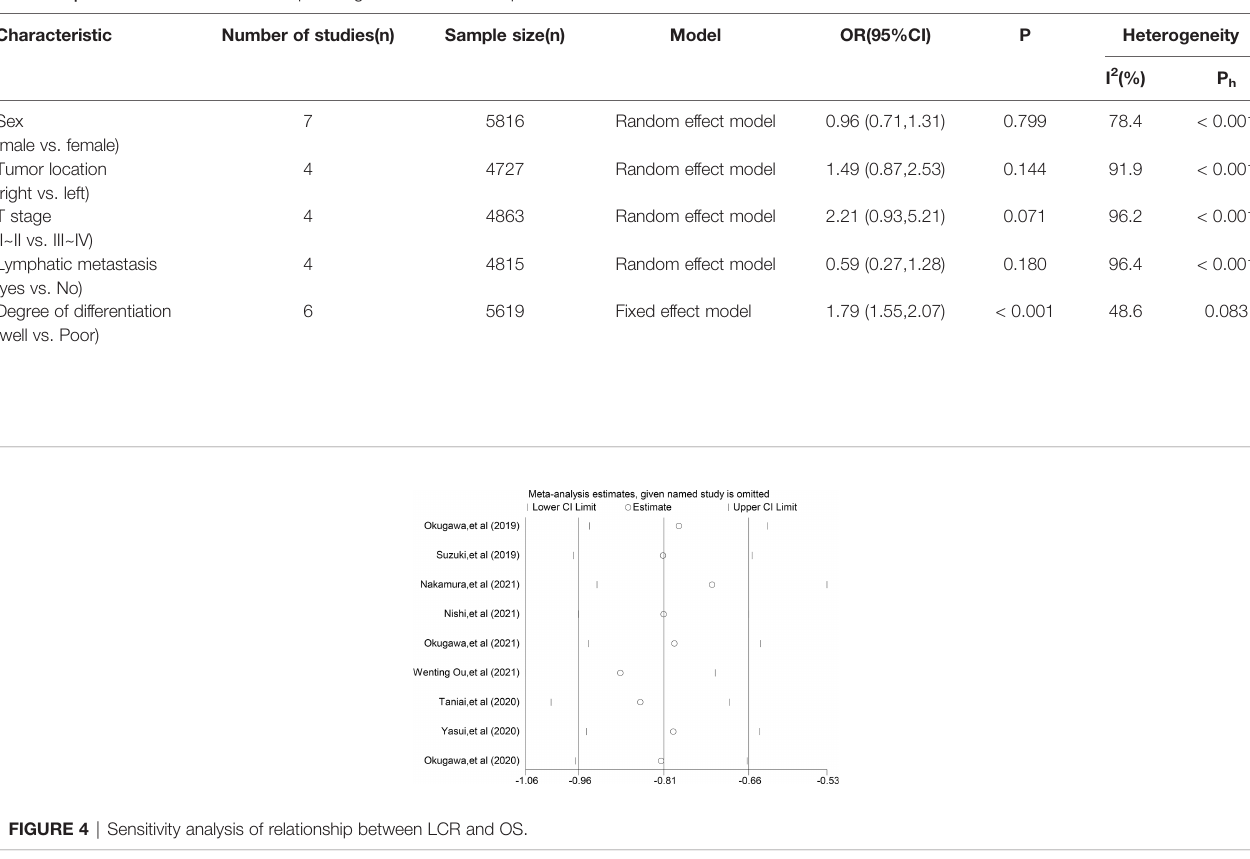
TABLE 3 | Relations of LCR with clinicopathologic characteristics in patients with colorectal cancer.